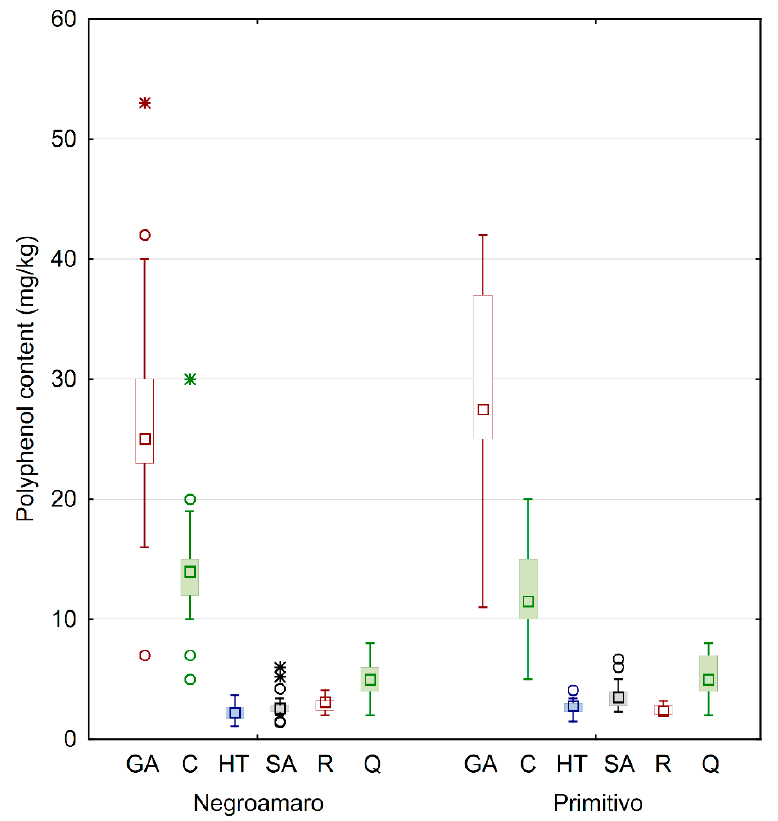
Figure 2. Box and whiskers plot of the analyzed phenols grouped by type of wine. The squares inside of boxes are median values. The height of the box is equal to the interquartile distance, indicating the distribution for 50% of the data. The whiskers outside the box represent non-outlier data, while circles and stars represent outlier and extreme values, respectively. GA: gallic acid; C: catechin; HT: hydroxytyrosol; SA: syringic acid; R: trans -resveratrol; Q: quercetin.